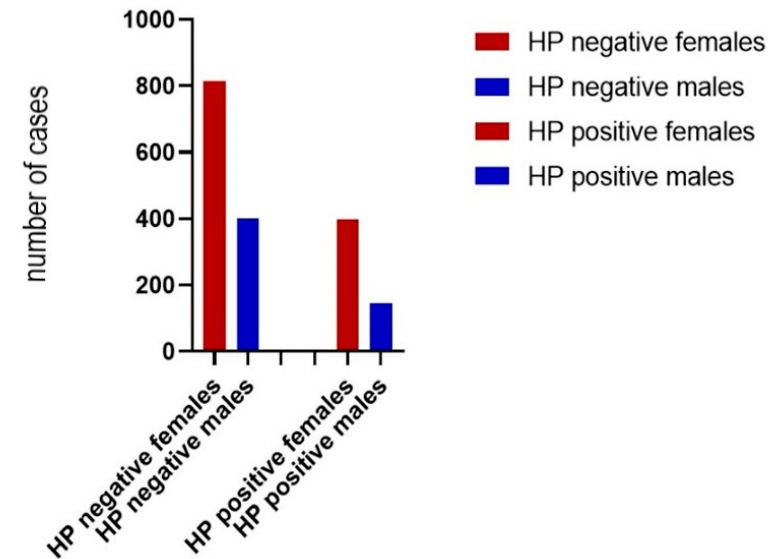
Figure 3. Structure of the batch of patients with or without H. pylori infection by gender.